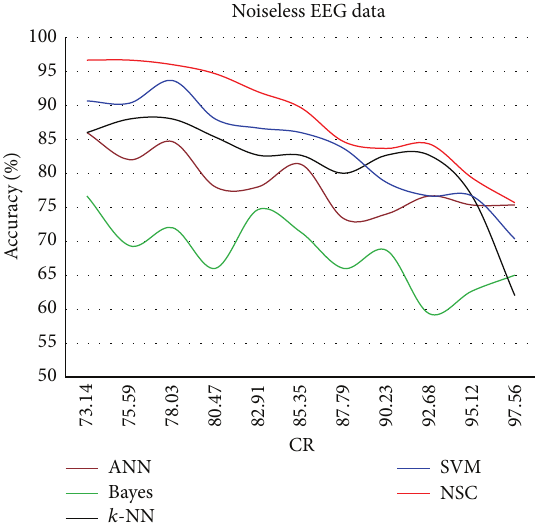
Figure 4: Classification accuracy against CR for noiseless